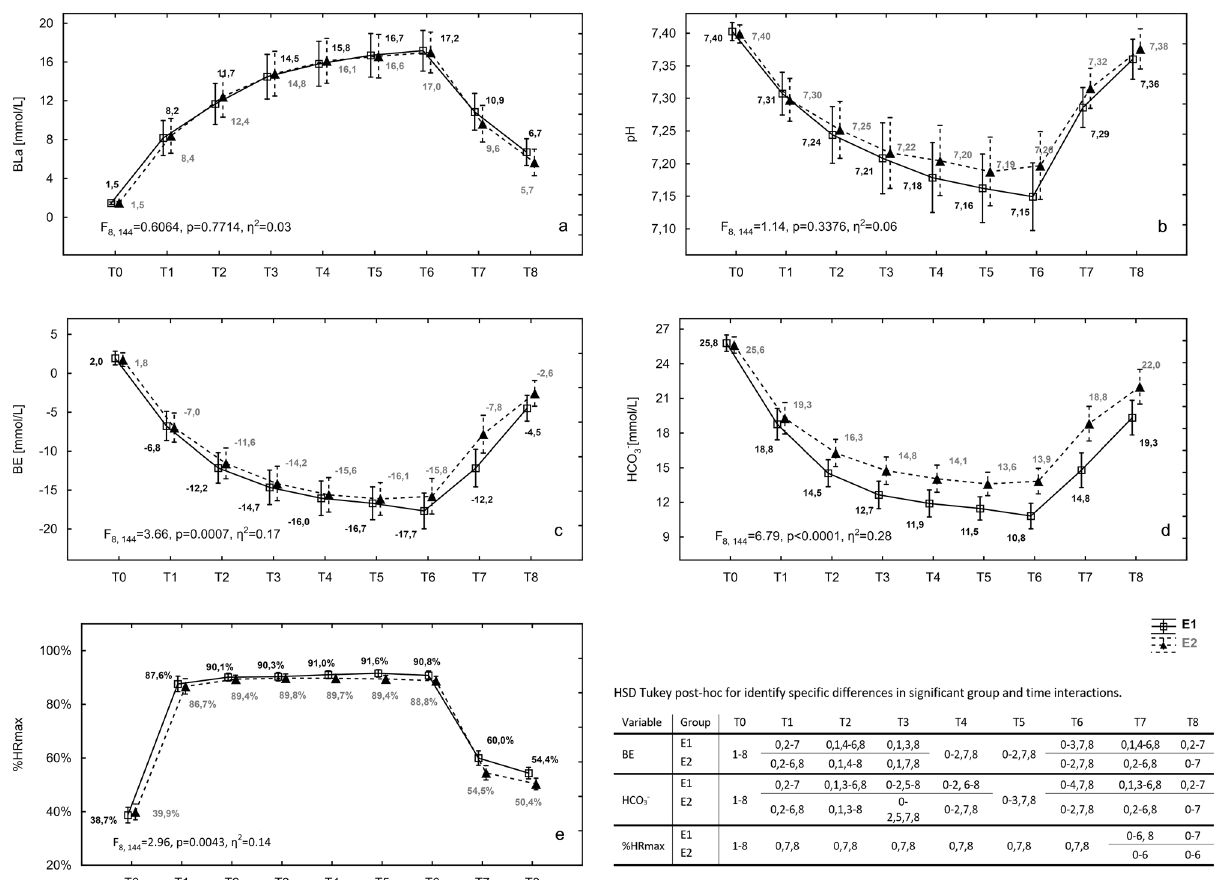
Figure 2. Interaction of the group and time effect for ITL variables with their specific differences (HSD Tukey post-hoc). E1—6 × 30 s 1 × 1 SSGs; E2—6 × 45 s 1 × 1 SSGs; BLa—blood lactate level; pH—blood pH; BE—base excess; HCO 3 − —blood bicarbonate; %HRmax—percentage of maximum heart rate; T0—before first SSG, T1— after first SSG; T2—after second SSG; T3—after third SSG; T4—after fourth SSG; T5—after fifth SSG; T6—after sixth SSG; T7—15 min after sixth SSG; T8—30 min after sixth SSG.